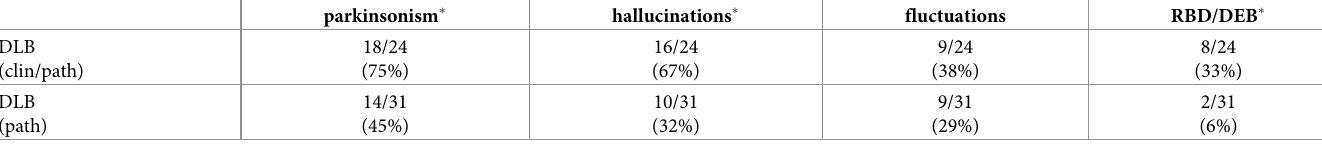
Table 3. Prevalence of DLB core features in AD-DLB subjects with and without a clinical DLB